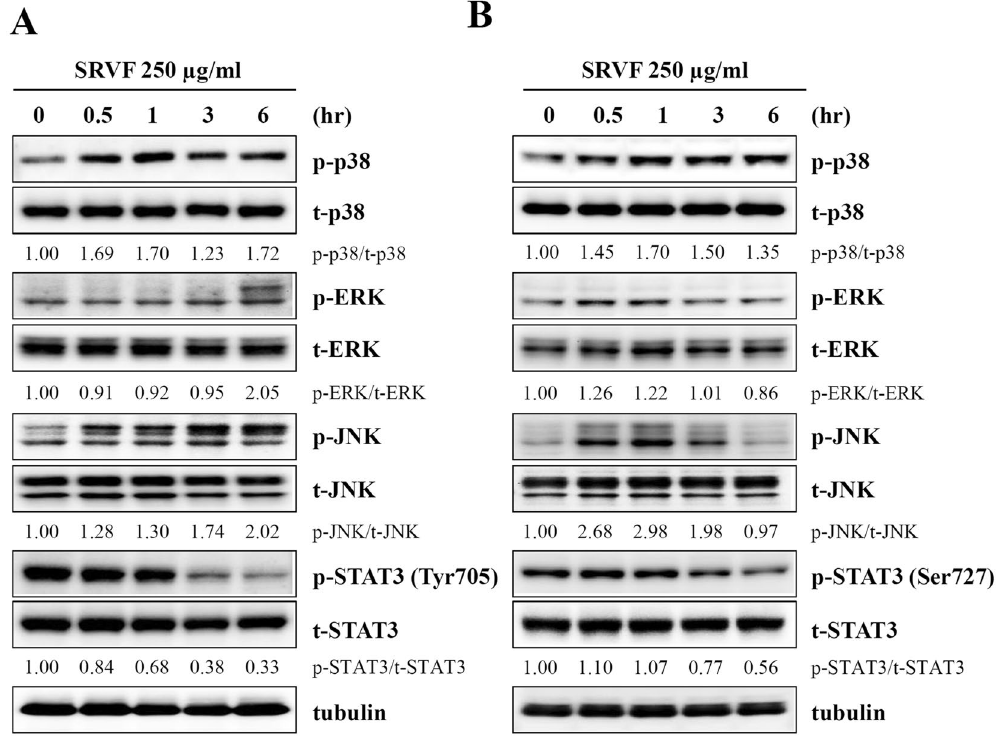
Figure 5. SRVF increases the phosphorylation of MAPK and decreases that of STAT3 in cancer cells. ( A,B ) HT1080 ( A ) and MDA-MB231 ( B ) cells were treated with 250 μg/ml SRVF for 0.5, 1, 3, or 6 h, and the levels of total and phosphorylated p38, ERK, JNK, and STAT3 were determined by Western blotting. Data are representative of two independent experiments and band intensities were calculated using ImageJ software after normalizing to tubulin expression. The full size blot is shown in Supplementary Fig.